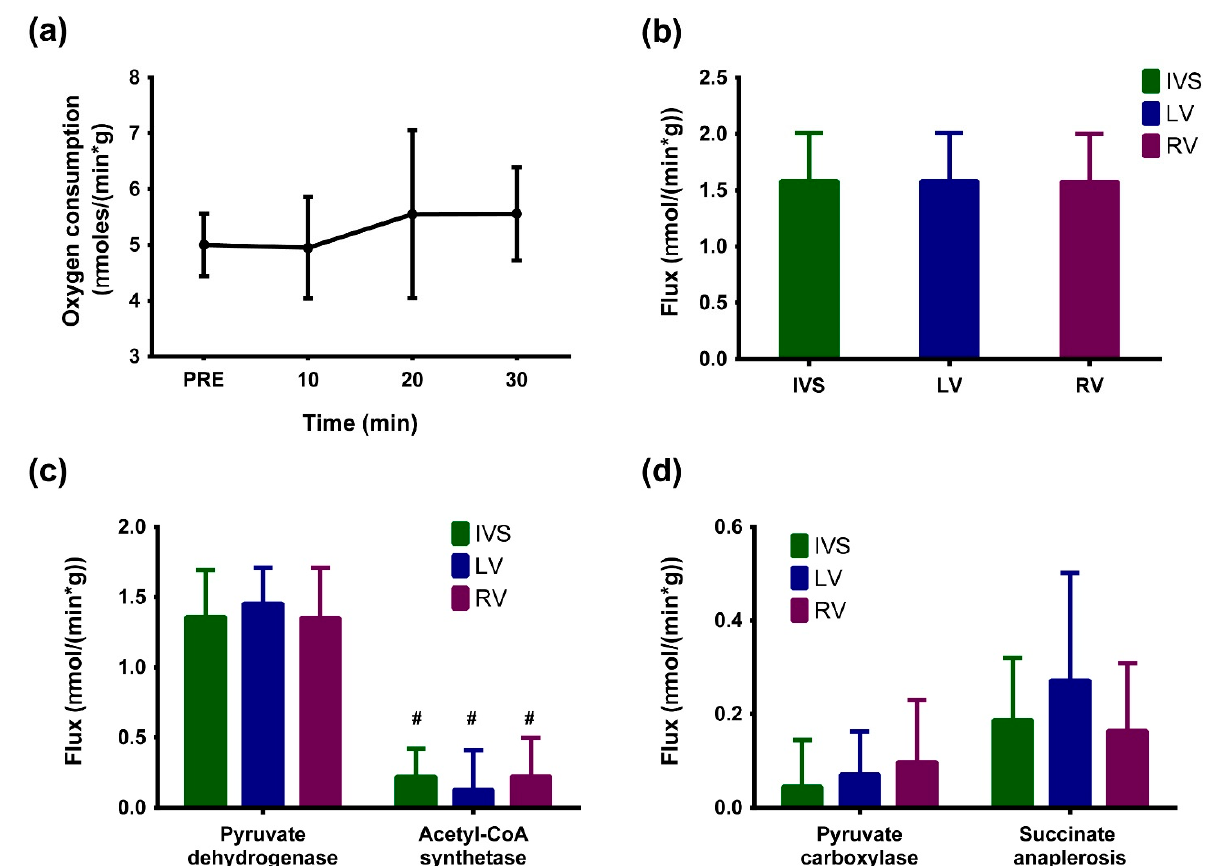
Figure 3. ( a ) Myocardial oxygen consumption measured during the course of [U- 13 C] glucose infusion ( n = 4). “PRE” refers to myocardial oxygen consumption prior to start of infusion. ( b ) Citric acid cycle turnover in intraventricular septum (IVS), left ventricle (LV), and right ventricle (RV) sections of fetal heart. Oxygen consumption averaged over 30 min is used to obtain absolute citric acid cycle flux. ( c ) Fluxes through pyruvate dehydrogenase (PDH) and acetyl-CoA synthetase (ACS) representing sources of acetyl-CoA in different sections of the fetal heart. # indicates statistical significance (PDH vs. ACS for each section of the heart; p < 0.001; two–tailed Student’s t –test) ( d ) Fluxes through anaplerotic pathways in different sections of the fetal heart. A minimal metabolic model including explicit definitions of pyruvate dehydrogenase flux, pyruvate carboxylase flux, and succinate anaplerosis was used to fit the data and obtain estimates shown in ( b – d ). Error bars in all panels are standard deviation ( n = 5; 2 males and 3 females).